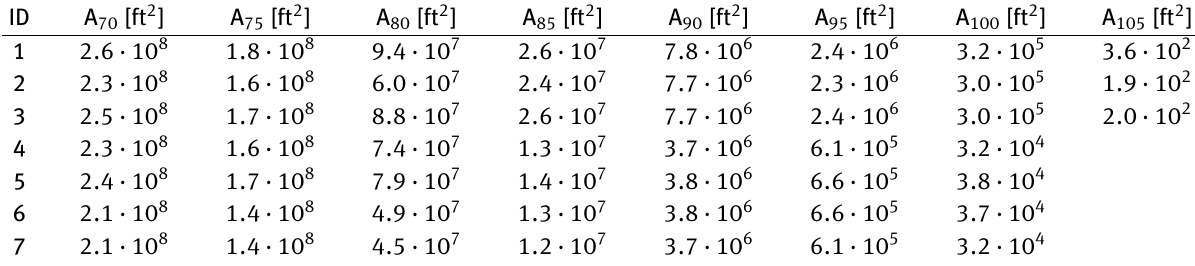
Table 10: SEL contoured areas for Piper PA-31-350 Navajo Chieftain. Case ID corresponding to Table 6. ID A 70 [ft 2